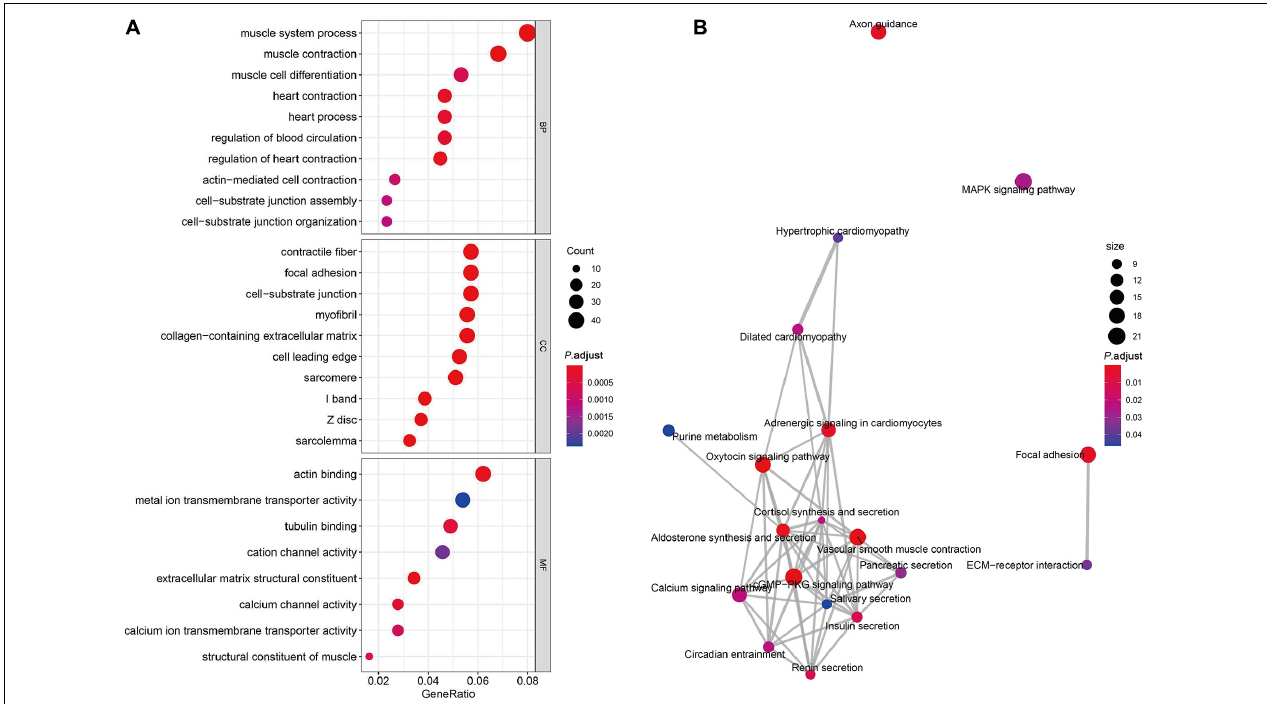
FIGURE 2 | GO enrichment and pathway analysis. (A) Significantly enriched pathways of the DEGs in BP, MF, and CC were revealed by GO analysis. DEGs, differentially expressed genes; BP, biological process; MF, molecular function; CC, cellular component; GO, Gene Ontology. (B) The complex interaction network among the significantly enriched KEGG